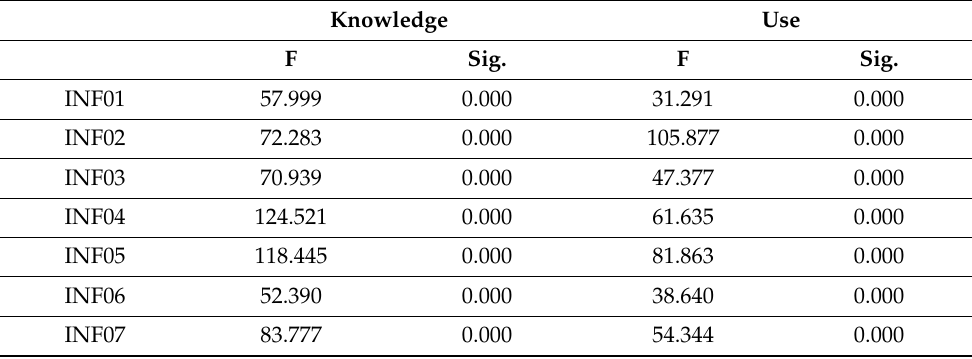
Table A13. ANOVA: knowledge and use of information access and management